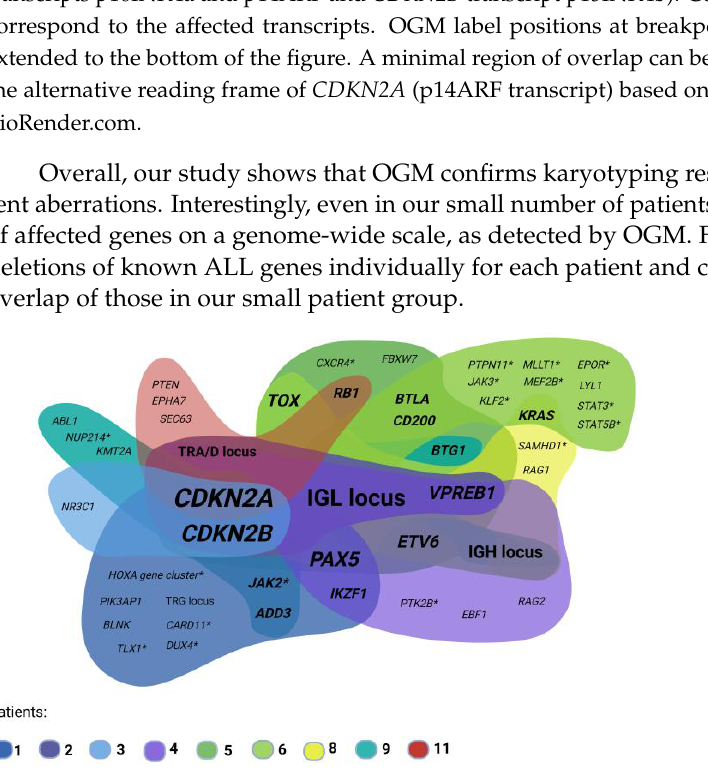
Figure 4. ALL-gene deletions/partial deletions overlap in the studied patient group. Single patients are visualized by unique color clouds. Gene cloud overlap shows frequency of affected genes: bigger font size corresponds to higher deletion frequency in the analyzed patient samples; core genes CDKN2A/CDKN2B are most frequently (partially) deleted and are visualized with the biggest font. Deletions in genes only detected in single patients show smallest font size. * Indicates ALL-associ- ated genes with unknown effect of gene deletions. Legend describes patient numbers. Created with BioRender.com. 4. Discussion Standard karyotyping is often not sufficient to completely reveal the true nature of cancer cell karyotypes because of complex aberrations. OGM is capable of detecting gene fusions at a higher resolution compared to karyotyping without the necessity to preselect specific target genes to be analyzed by FISH or RT-PCR because multiple information can be acquired with only one methodology. Besides, as a whole genome approach, OGM can also detect relevant, novel SVs. In our patient group, five translocations were detected via classical karyotyping. Three of them were BCR::ABL1 fusions, the most frequent fusion in adult ALL patients. Another was a t(12;22)(p13;q13), characterized by FISH as a ZNF384 rearrangement. Using OGM, the fusion partner EP300 could be identified. EP300 is rarely found as a fusion partner and was estimated to occur in around 1% of pediatric patients by Gocho et al. [38]. Hirabayashi et al. (2017) discovered a distinct immune phenotype for ZNF384 -related fusion genes, with low or negative expression for CD10 and aberrant ex- pression of CD13 and/or CD33 [25]. However, EP300::ZNF384 -associated loss of CD10 ex- pression is in line with our patients’ results in flow cytometry. EP300::ZNF384 fusions show a better response to steroid monotherapy as well as conventional chemotherapy and present with no significant elevation of WBC, while ZNF384 -fusions with a different part- ner gene, TCF3 , result in an elevated WBC level and poor response to prednisolone and conventional chemotherapy [25,38]. Thus, OGM is not only a useful tool for the detection of rare and unknown fusion partners but also opens the possibility of individualizing therapy. 4.1. OGM Can Detect Rare Gross Structural Rearrangements A ring chromosome 9 could be redefined in one patient by manual inspection of the data, outperforming karyotyping and FISH. Similarly, the presence of an idic(8q) is very likely based on OGM data in one patient, representing another putative aberration not detected in the initial chromosome analysis. The missed detection of an idic could be due to culture artifacts because repeated cell divisions might have resulted in the loss of the